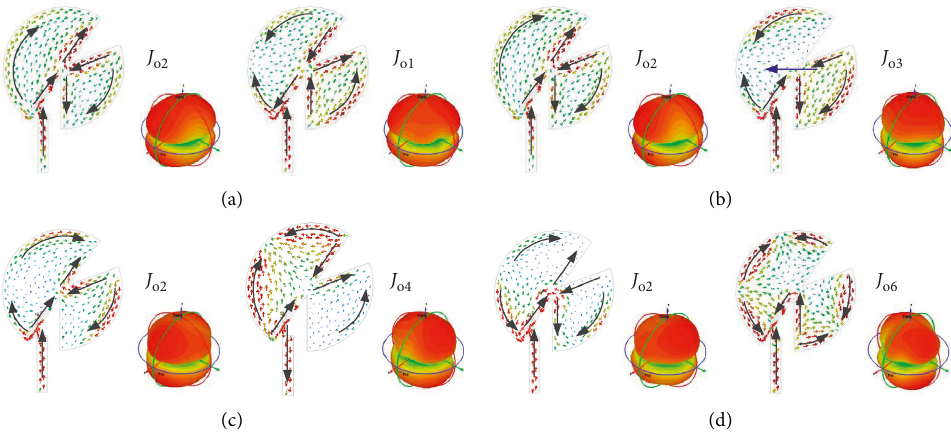
Figure 10: Modal currents and radiation patterns for Proto B of (a) modes J J o 2 and J o 4 at 6GHz. (d) Modes J o 2 and J o 6 at 7GHz.